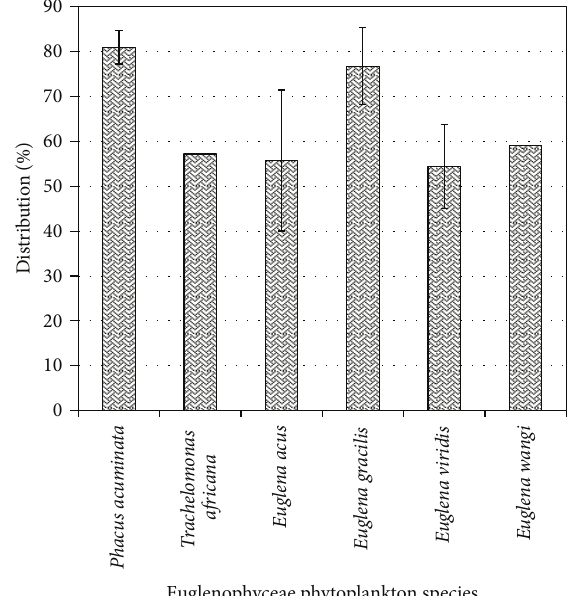
Figure 10: Overall mean values of Euglenophyceae species in Okpoka